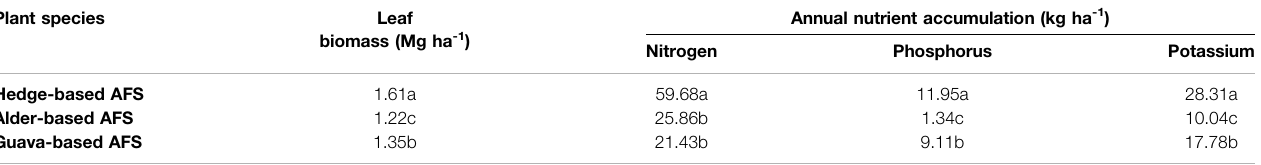
TABLE 6 | Biomass production and annual nutrient accumulation by agroforestry system in the Indian sub-Himalayas. Plant